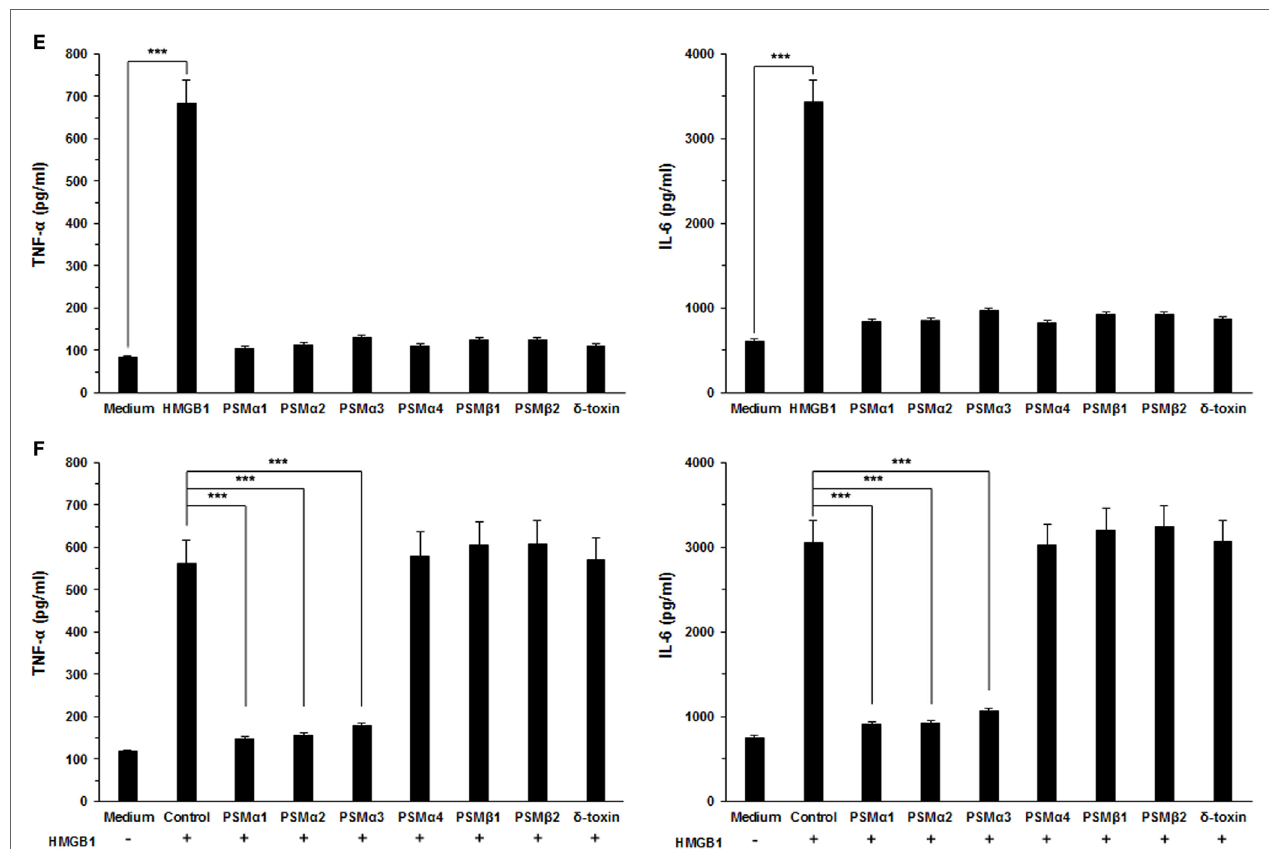
FigUre 4 | Staphylococcus aureus phenol-soluble modulins (PSMs) α 1– α 3 inhibit HMGB1-induced inflammatory response. (a) THP-1 cells were transfected with a NF- κ B-dependent luciferase reporter. The luciferase activity of THP-1 cells was measured after stimulated with 1.0 µg/mL recombinant HMGB1 or S. aureus PSMs (PSM α 1, 5 µg/mL; PSM α 2, 5 µg/mL; PSM α 3, 0.5 µg/mL, PSM α 4, 5 µg/mL; PSM β 1, 10 µg/mL; PSM β 2, 10 µg/mL; δ -toxin, 2 µg/mL). (B) The NF- κ B activity of THP-1 cells challenged with HMGB1 in the presence and absence of S. aureus PSMs as prior described. The values for medium treated cells were